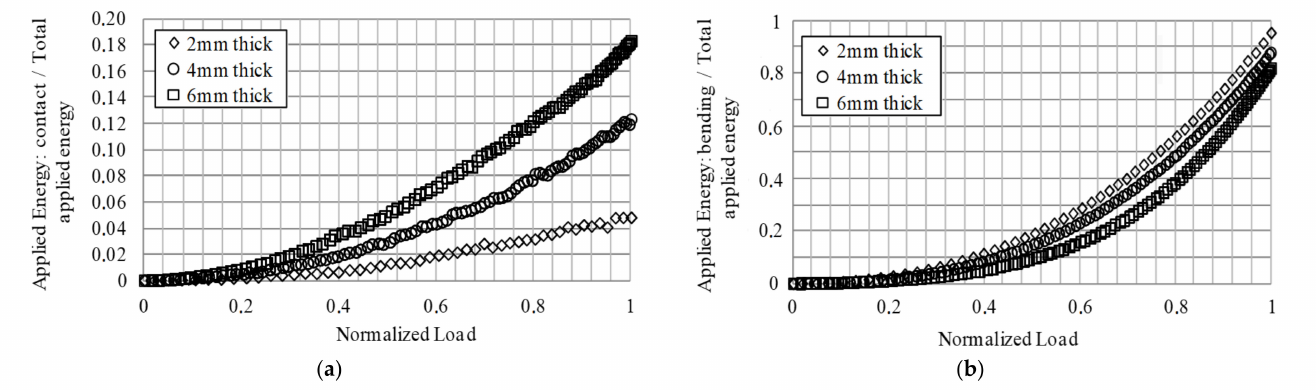
Figure 10. ( a ) Normalized evolution of the applied energy due to contact versus normalized load for different speci- men thicknesses. ( b ) Normalized evolution of the applied energy due to bending versus normalized load for different specimen